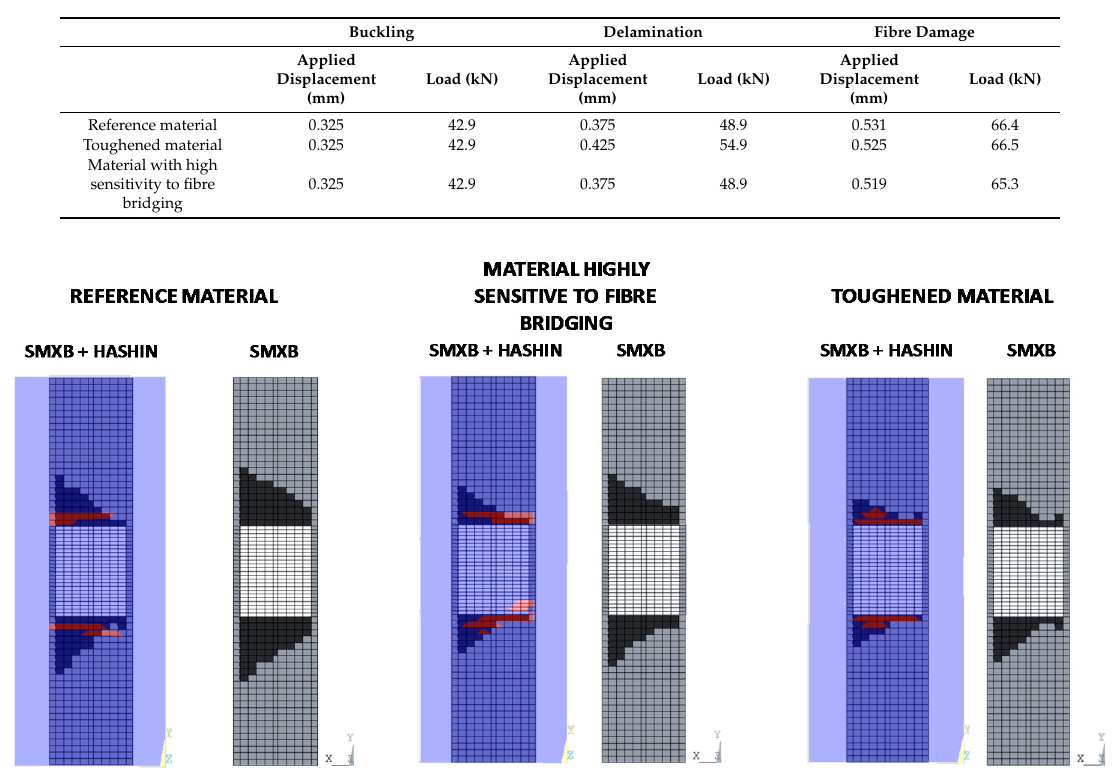
Materials 2019 , 12 , x FOR PEER REVIEW Figure 12. Delamination evolution comparison. Figure 12. Delamination evolution comparison.